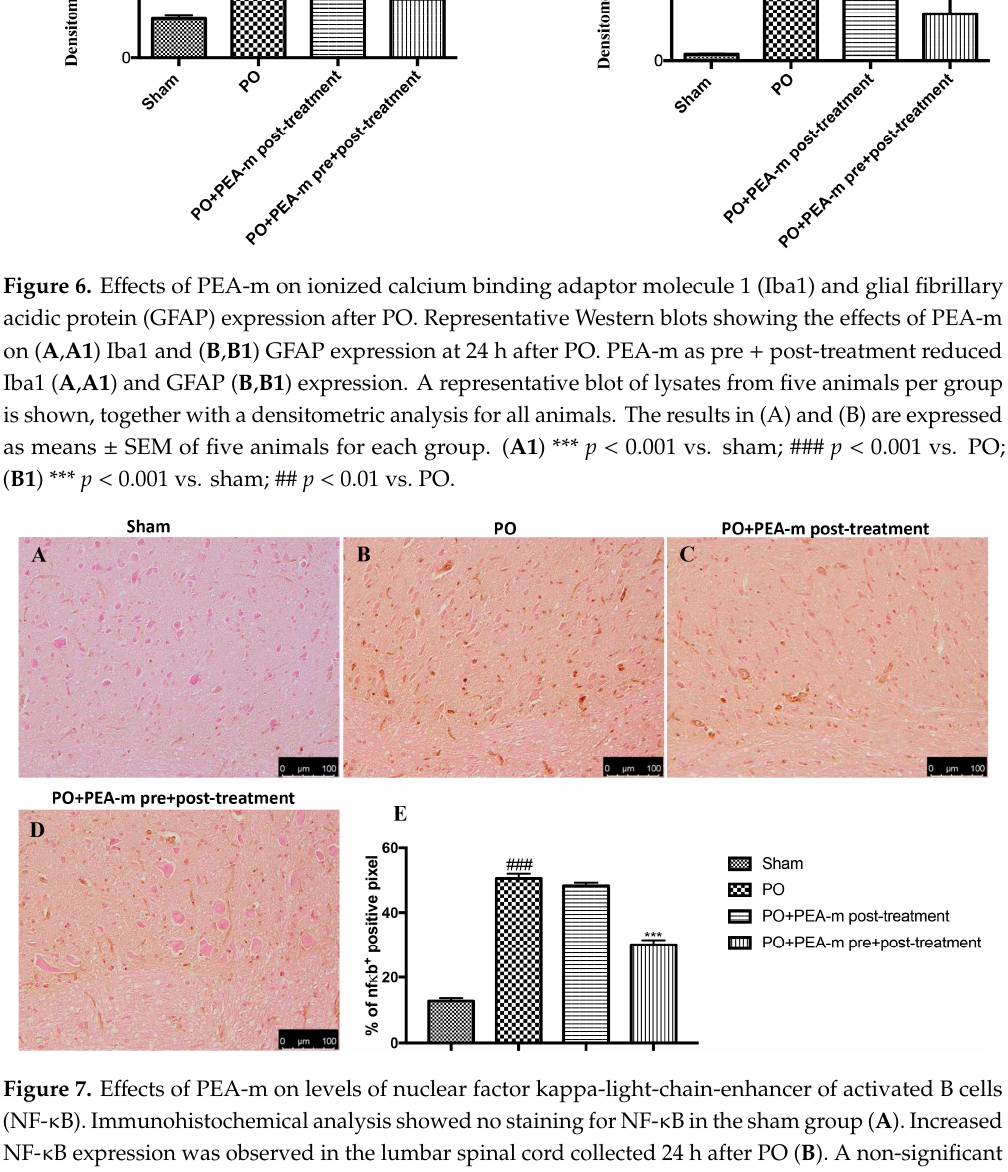
Figure 6. Effects of PEA-m on ionized calcium binding adaptor molecule 1 (Iba1) and glial fibrillary acidic protein (GFAP) expression after PO. Representative Western blots showing the effects of PEA- m on ( A , A1 ) Iba1 and ( B , B1 ) GFAP expression at 24 h after PO. PEA-m as pre + post-treatment reduced Iba1 ( A,A1 ) and GFAP ( B , B1 ) expression. A representative blot of lysates from five animals per group is shown, together with a densitometric analysis for all animals. The results in (A) and (B) are expressed as means ± SEM of five animals for each group. ( A1 ) *** p < 0.001 vs. sham; ### p < 0.001 vs. PO; ( B1 ) *** p < 0.001 vs. sham; ## p < 0.01 vs. PO.